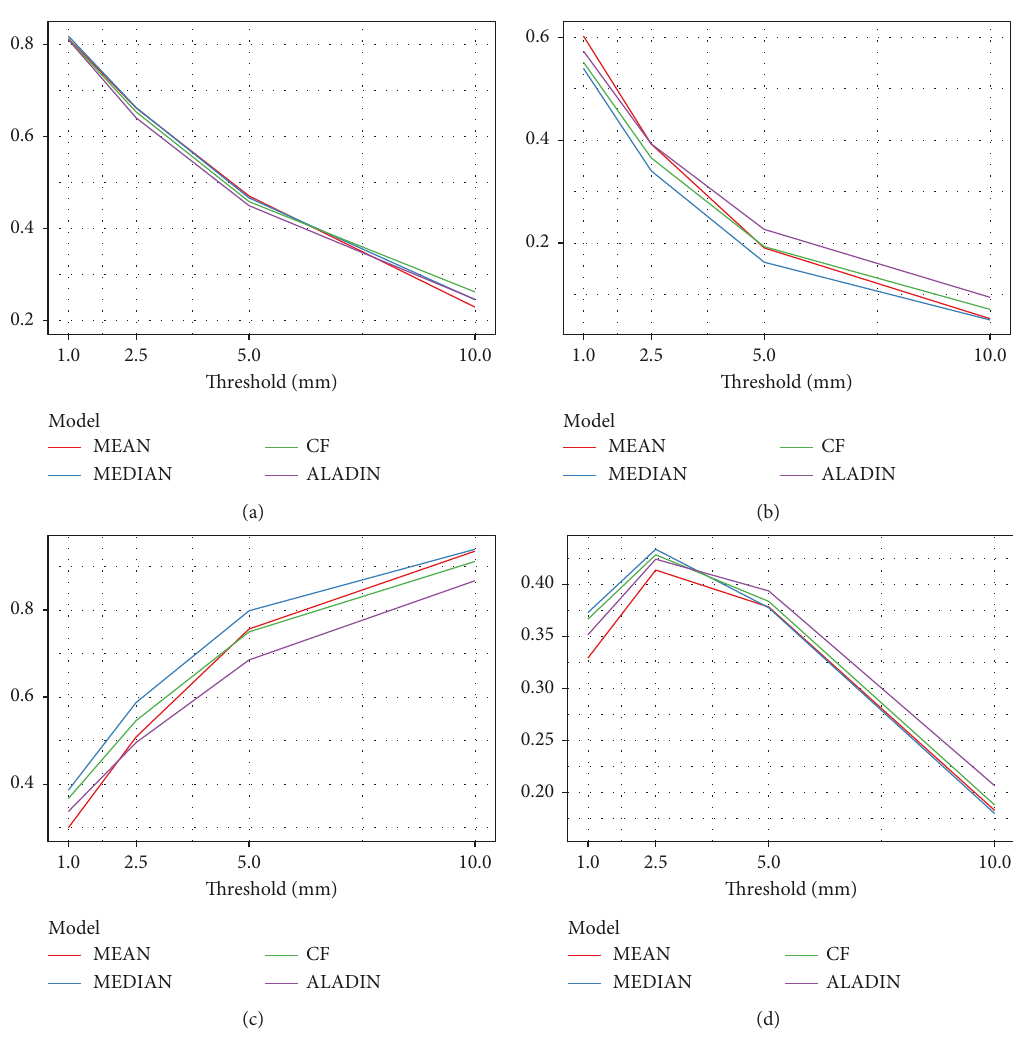
Figure 4: Comparison of ALADIN (purple), MEAN (red), MEDIAN (blue), and CF (green) for POD (a), TS (b), FAR (c), and BS (d) as a function of thresholds. Grey lines represent 16 ensemble members. In case of BS, the ensemble is represented by single grey